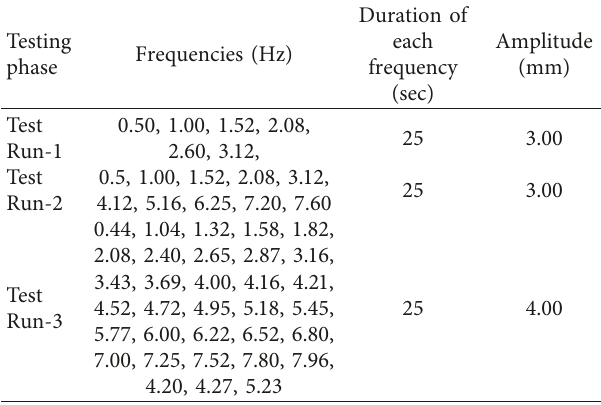
Table 3: Actual input motion simulated in different phases of experiment.